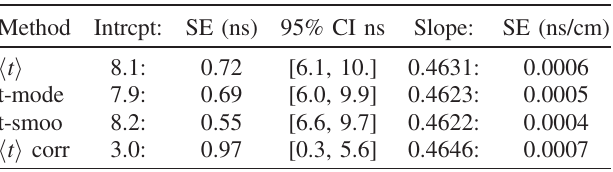
TABLE III. Fit statistics for shot 2584. For each method,